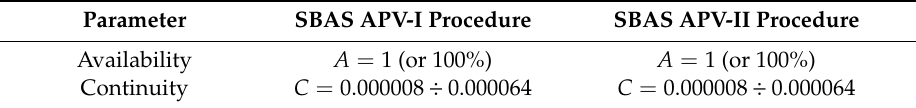
Table 6. Values of availability and continuity term in the air test in Chełm.